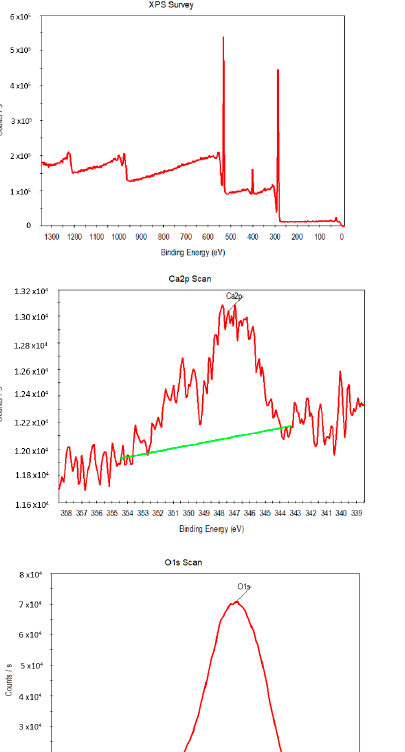
Figure 7. X-ray photoelectron spectroscopy—L-glu spheres crystallized from 54 mM L-glu and 11 mM Ca 2+ ions.